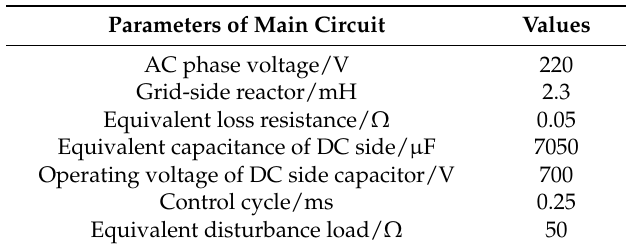
Table 1. Parameters of the main circuit.